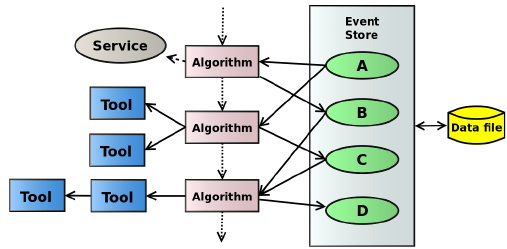
Figure 1. General structure of an Athena